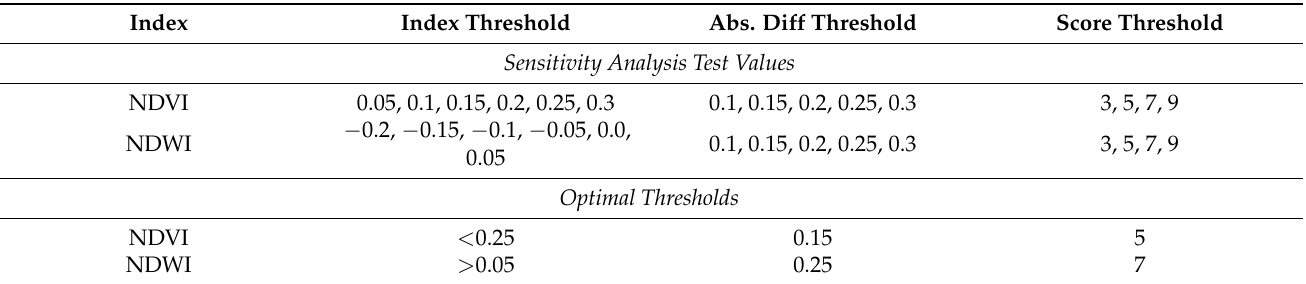
Table 2. The upper part of the table provides the range of values tested during the sensitivity analysis to identify the optimal thresholds for the change analysis. The index threshold is the threshold to find a potential mangrove loss within an individual scene. The absolute difference threshold is the difference in the index between the current scene and the median pixel value for the month from the previous year. The score threshold is related to the number of times a change needs to have occurred for the mangrove loss alert to be confirmed. The bottom part of the table provides the resulting optimal thresholds identified through the sensitivity analysis. Acronym definitions: normalised difference vegetation index (NDVI), normalised difference water index (NDWI).